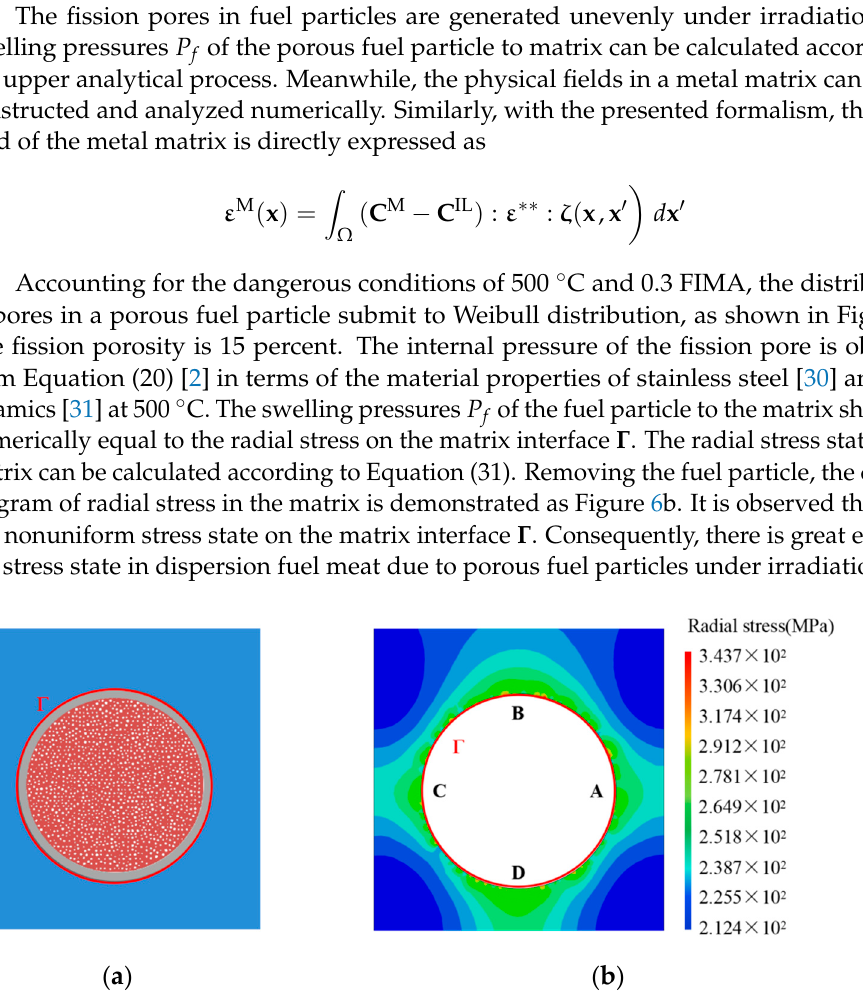
Figure 6. Analytical results for the irradiation swelling pressure of a porous fuel particle at dangerous conditions of 500 ◦ C and 0.3FIMA. ( a ) Structure of a porous fuel particle; ( b ) Contour diagram of radial stress in the